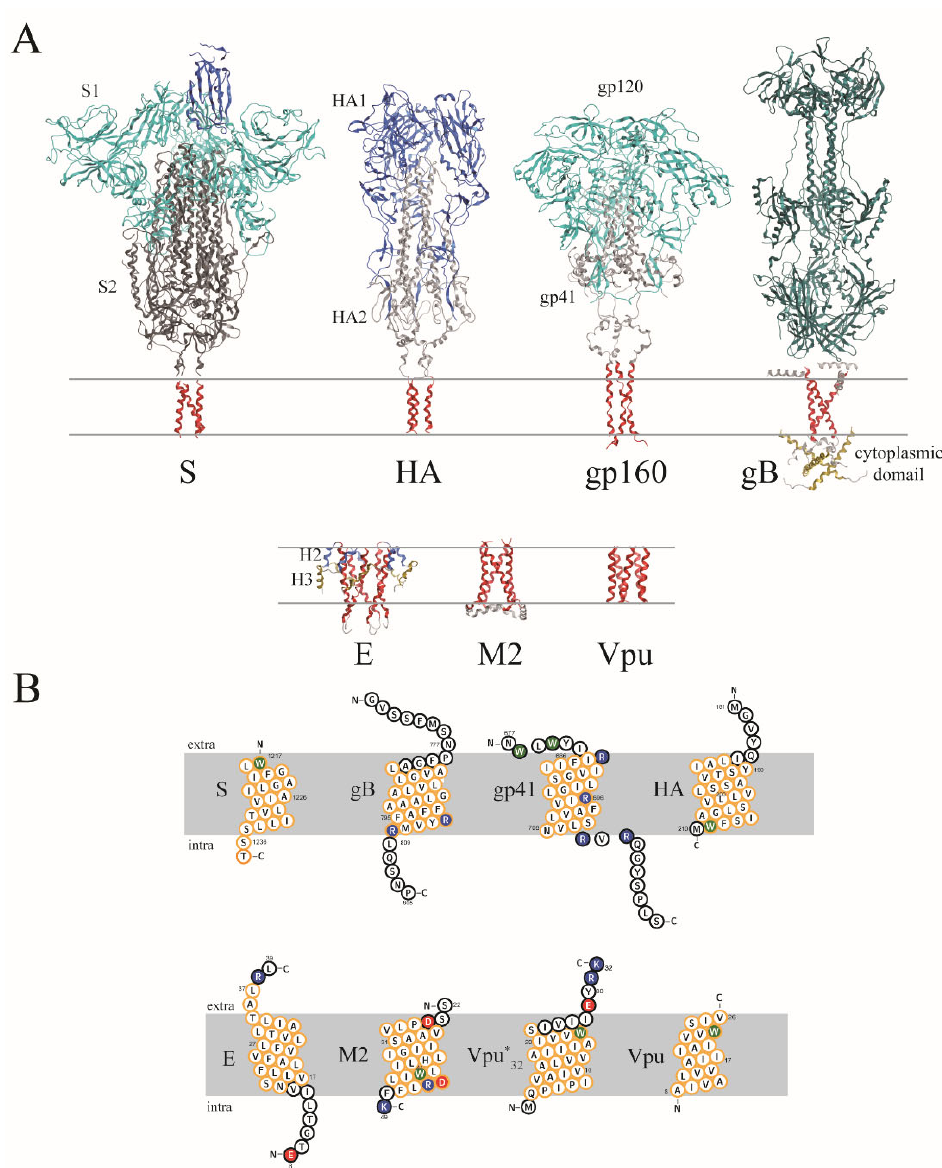
Figure 1. ( A ) Models in their backbone representation of fusion proteins based on experimental data for S protein of S1 and parts of S2 (combined PDB ID: 6VSB and PDB ID: 7LC8 (TMD) for visualization only), haemagglutinin (PDB ID: 6HJQ), gB (PDB ID: 5V2S) and gp160 (combined use of PDB ID: 6PWU (gp120 and parts of gp41), and PDB ID: 6E8W (linker and transmembrane domain of gp41) for visualization only), as well as the viral channel forming proteins (VCPs) M2 (PDB ID: 2L0J), E protein (PDB ID: 5X29) and Vpu (PDB ID 1PI7). The TMDs are shown in red, while the extra-membrane domains are shown in different colors, highlighting the different subdomains. Different subunits of the proteins are marked as S1/2 or HA1/2. The lipid membrane is approximated by two lines. ( B ) The sequence and topology of the fusion proteins (upper row) and VCPs (lower row), which are used in the simulations, are shown using the program ‘Protter’. The residues assumed to be within the lipid membrane are embedded within the grey bar. Residues encircled in orange are residues chosen for the calculation of the diffusion coefficient using spp. Positively charged residues are shown in blue; the negatively charged residues in red. Tryptophan residues are highlighted in green. Extra-membrane residues are manually reorganized in the plots.